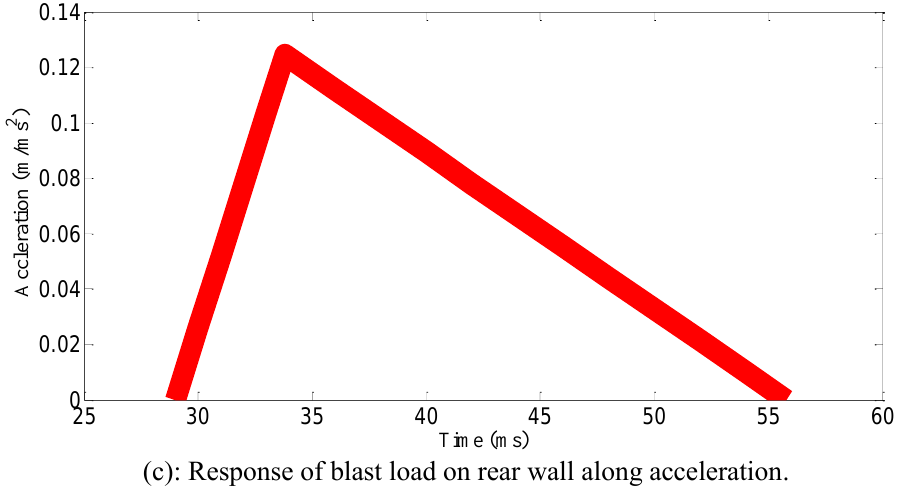
(c): Response of blast load on rear wall along acceleration. Fig. 6. Response of blast load on rear wall with respect to time.